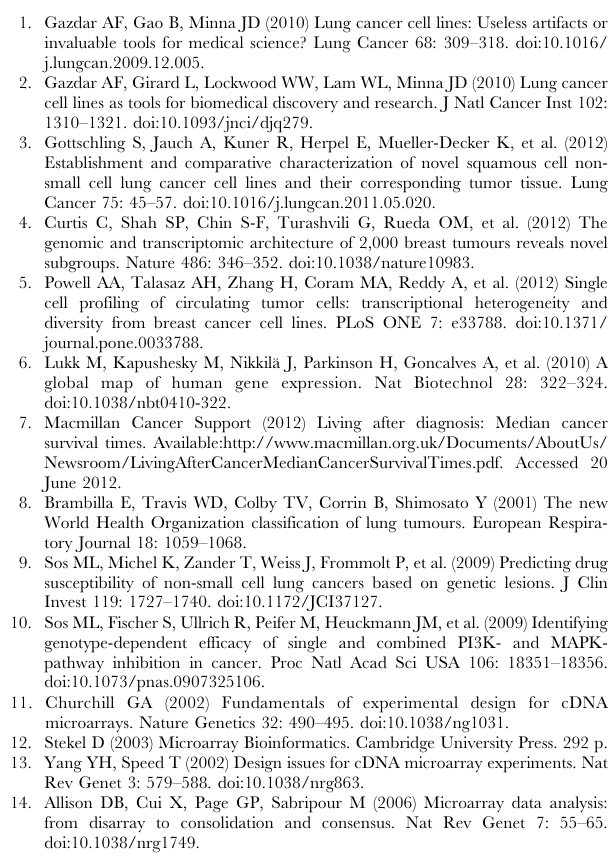
Figure S35 Heatmap for the differentially expressed genes between clusters 2 and 3 after Normalisation with FARMS and Golub filtering for 1000 probes. (TIFF) Figure S36 Heatmap for the differentially expressed genes between clusters 2 and 3 after Normalisation with GCRMA and IQR filtering for 300 probes. (TIFF) Figure S37 Heatmap for the differentially expressed genes between clusters 2 and 3 after Normalisation with GCRMA and IQR filtering for 1000 probes. (TIFF) Figure S38 Heatmap for the differentially expressed genes between clusters 2 and 3 after Normalisation with GCRMA and Golub filtering for 300 probes. Figure S39 Heatmap for the differentially expressed genes between clusters 2 and 3 after Normalisation with GCRMA and Golub filtering for 1000 probes. Figure S40 Heatmap for the differentially expressed genes between clusters 2 and 3 after Normalisation with RMA and IQR filtering for 300 probes. Figure S41 Heatmap for the differentially expressed genes between clusters 2 and 3 after Normalisation with RMA and IQR filtering for 1000 probes.